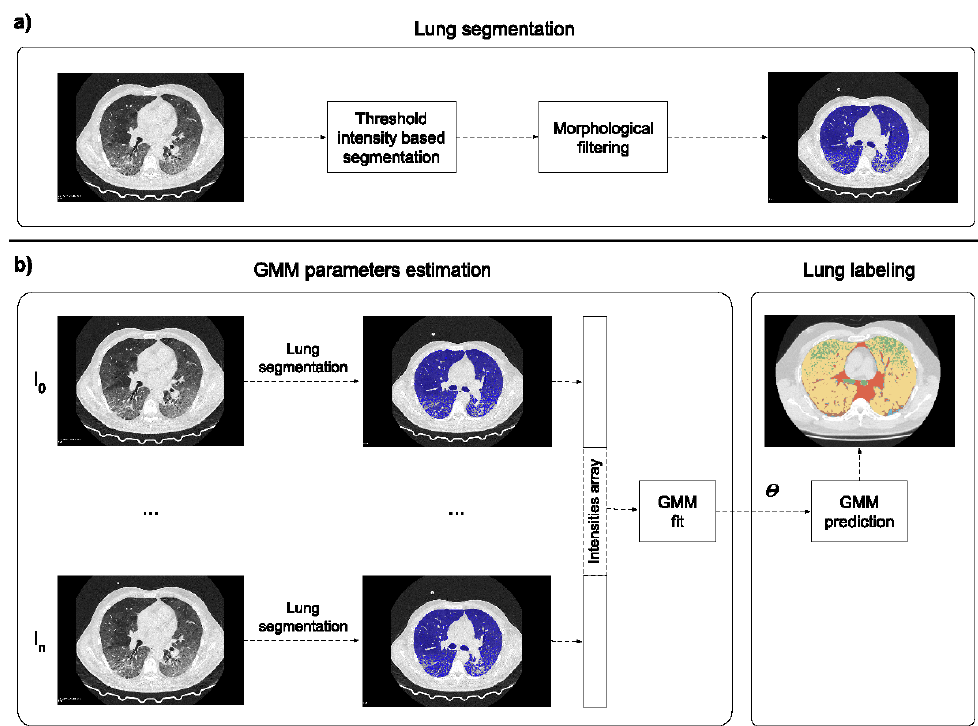
Figure 2. Proposed labeling pipeline split into lung segmentation (panel ( a )) and tissue labeling (panel ( b )). After lung region segmentation (performed by using the worklflow in ( a )), lung voxels of different computed tomographies (CTs) were represented as a single one-dimensional array used to fit a five-component Gaussian mixture model (GMM). Once the algorithm converged, each CT image was labeled using the estimated parameters ( θ